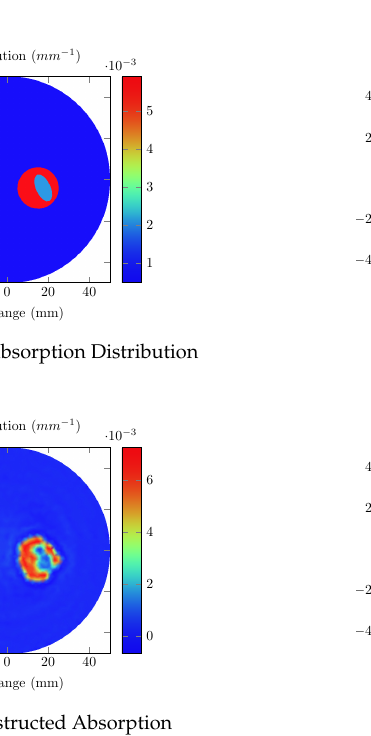
Figure 6. Total optical fluence distribution using an 800 nm wavelength source on the breast phantom. The background absorption coefficient is µ a = 0.0005 mm − 1 , with a reduced scattering coefficient µ (cid:48) s = 1.5742. Glandular tissue ( µ a = 0.0059 mm − 1 , µ (cid:48) s = 1.12 mm − 1 ) surrounds a tumor ( µ a = 0.0021, µ (cid:48) s = 0.625 mm − 1 ) located 32.5 mm deep from the right side of the phantom.